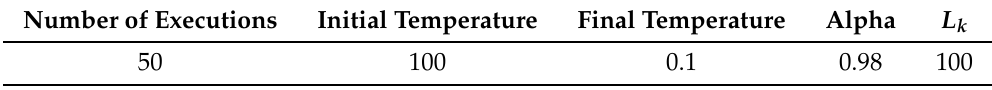
Table 2. Tuning parameters for CMOSA/CMOTA.